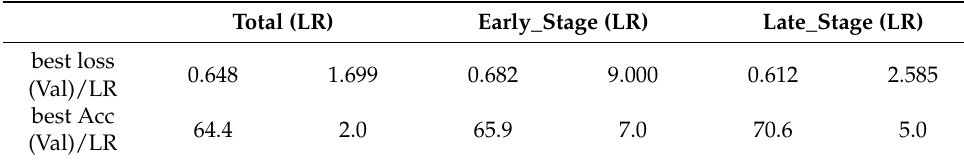
Table 5. Best loss(Val) and best Acc(Val) in total, early_stage, and late_stage with